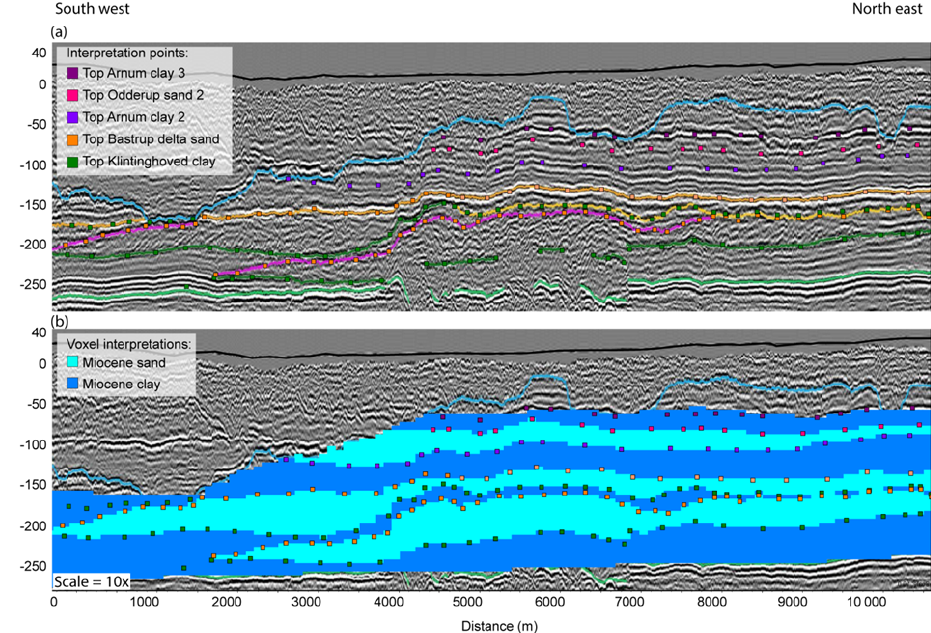
Figure 6. Preparation of seismic data input exemplified by a selected seismic section (for position, see Fig. 7). (a) The seismic section shown together with coloured horizons and interpretation points derived from the Miocene model (Kristensen et al., 2015). (b) The seismic section shown together with the generated “2-D voxel model”. Vertical exaggeration = 10 ×